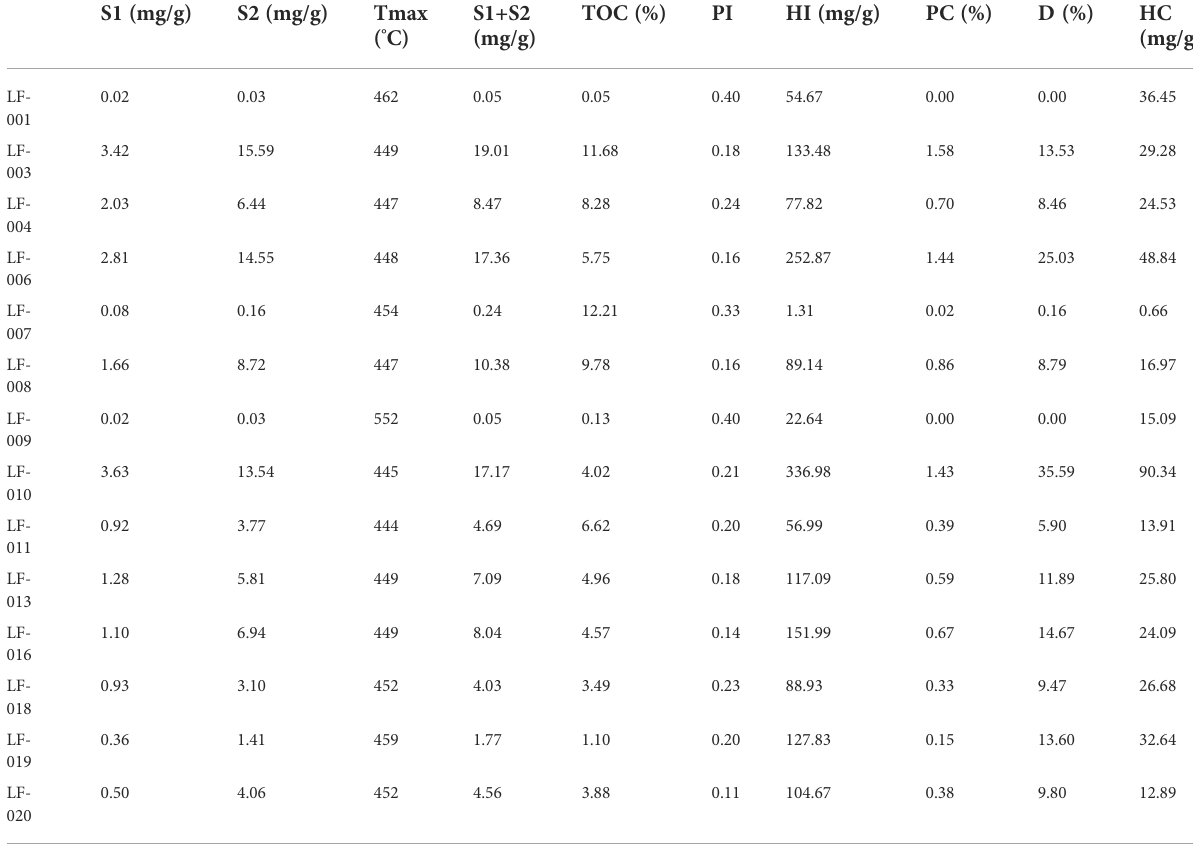
TABLE 1 Pyrolysis parameters of the source rocks of the Dalong Formation from Longfeng Quarry, Northwest Township, Guangyuan. S1